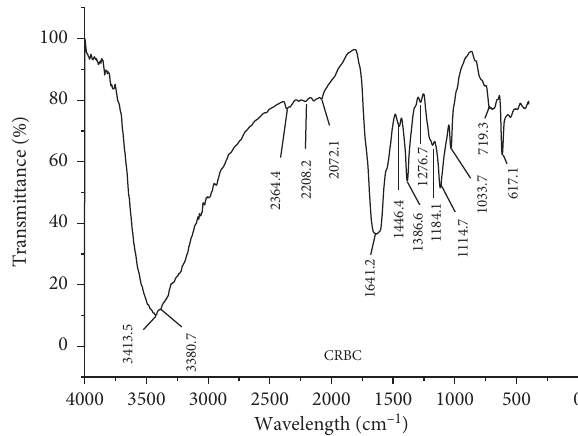
Figure 4: FT-IR spectrum for oxidation of CRBC by DPC (III) in alkaline